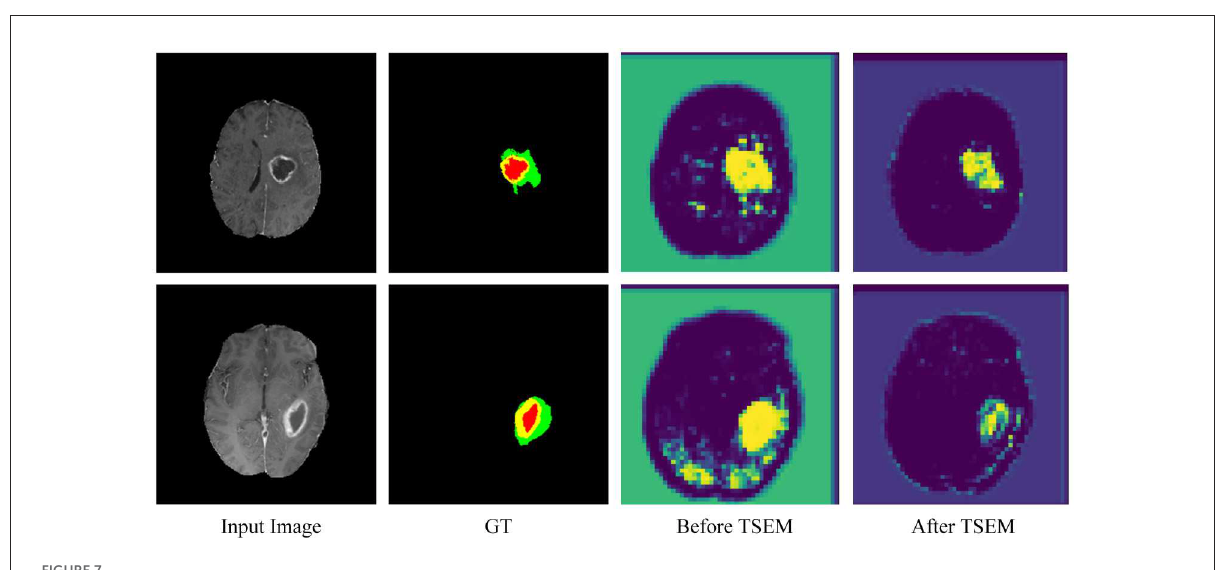
According to the comparison results, the proposed segmentation framework obtains better scores and achieves a more significant performance improvement compared with state-of-the-art segmentation models. The proposed segmentation model achieves an average Dice of 86.31% on the BraTS2018 dataset and an average Dice of 94.86% on the medical segmentation decathlon, which are better than other state-of-the-art segmentation